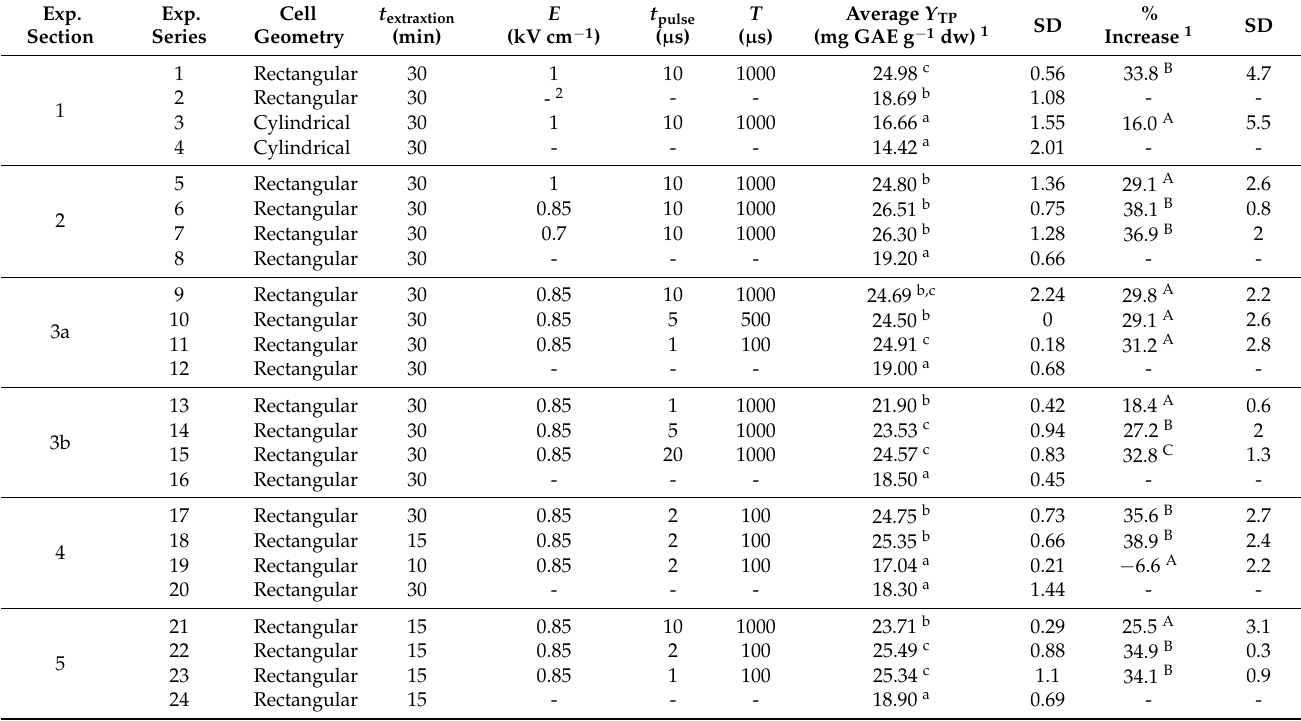
Table 2. Mean values of total polyphenol content (mg GAE g − 1 dw) of OLL extracts. Exp.